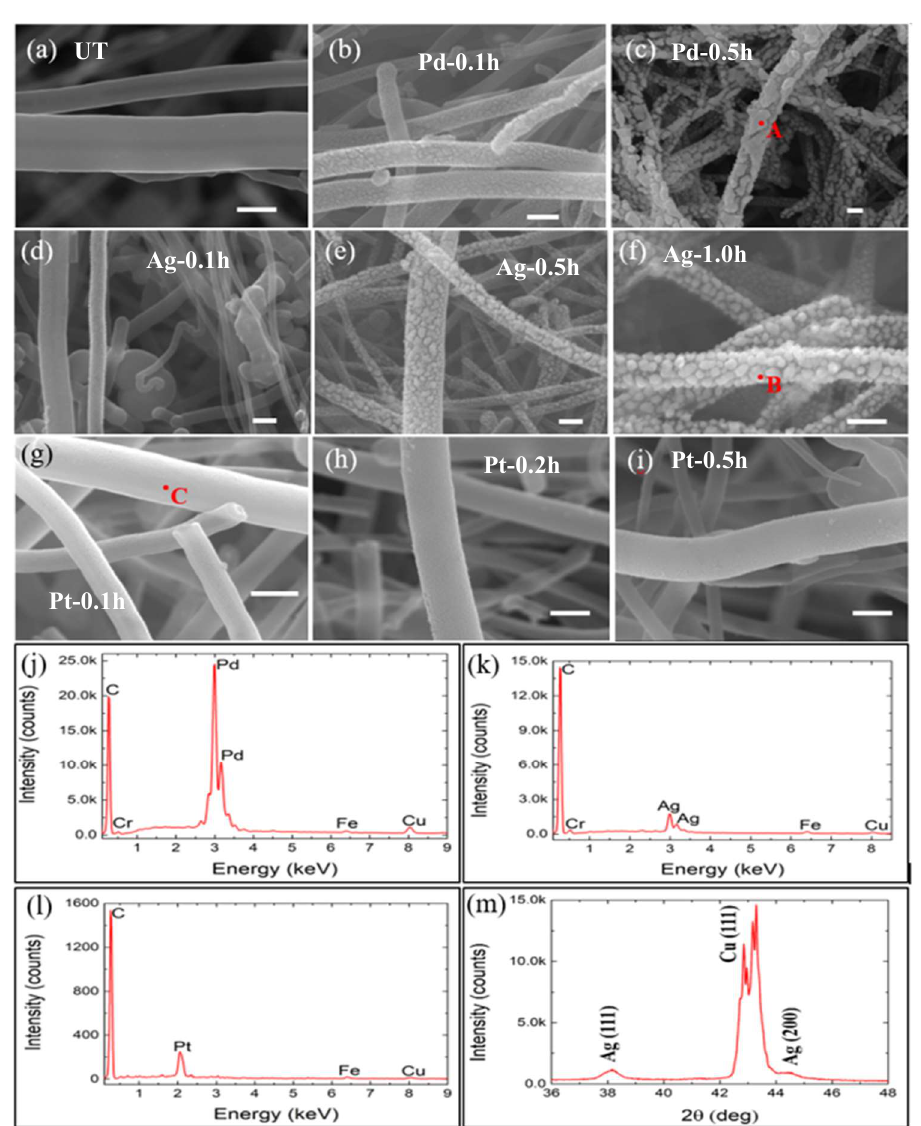
Figure 3. SEM images of: ( a ) untreated CNFs; ( b ) CNFs/Pd-0.1h; ( c ) CNFs/Pd-0.5h; ( d ) CNFs/Ag-0.1h; ( e ) CNFs/Ag-0.5h; ( f ) CNFs/Ag-1.0h; ( g ) CNFs/Pt-0.1h; ( h ) CNFs/Pt-0.2h; ( i ) CNFs/Pt-0.5h. All scale bars are representing 300 nm. EDX spectrum of: ( j ) CNFs/Pd-0.5h taken from spot ‘A’, denoted in ( c ); ( k ) CNFs/Ag-1.0h taken from spot ‘B’, denoted in ( f ); (l) CNFs/Pt-0.1h taken from spot ‘C’, denoted in ( g ). ( m ) XRD pattern indicating the phase of CNFs/Ag-0.5h.